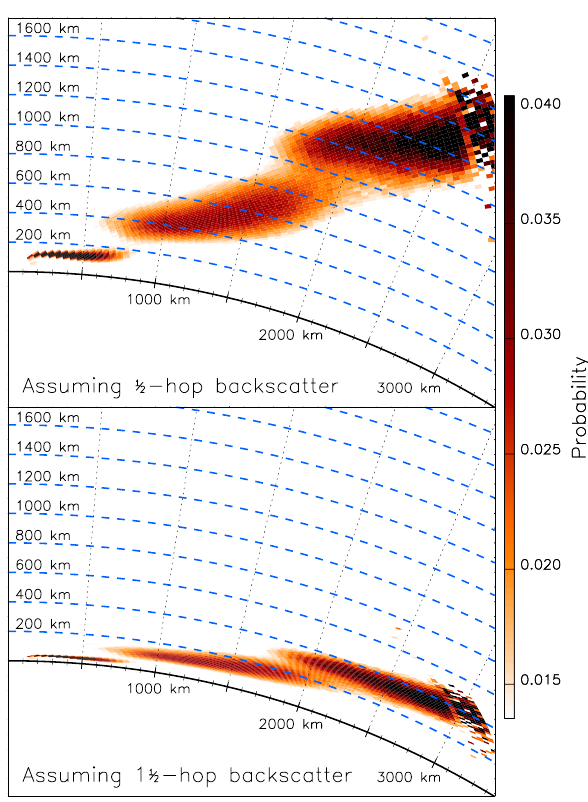
Fig. 4. The distribution of Saskatoon beam 3 backscatter from 1997–2001 inclusive transformed from range-elevation angle space to virtual height in real space by assuming a straight line virtual propagation path. The top panel presents the distribution when -hop propagation path is assumed, as in Fig. 1b. The bottom a 1 2 panel presents the distribution when a 1 1 -hop propagation path is 2 assumed, as in Fig. 1c. Only common mode backscatter with a line- of-sight velocity magnitude greater than 100m/s are included. The distribution in each range bin (45 km) has been normalised as in Fig. 3. The colour scale provides a key to the occurrence probabil- ity in each region; occurrence probabilities of less than 0.014 are shown as white